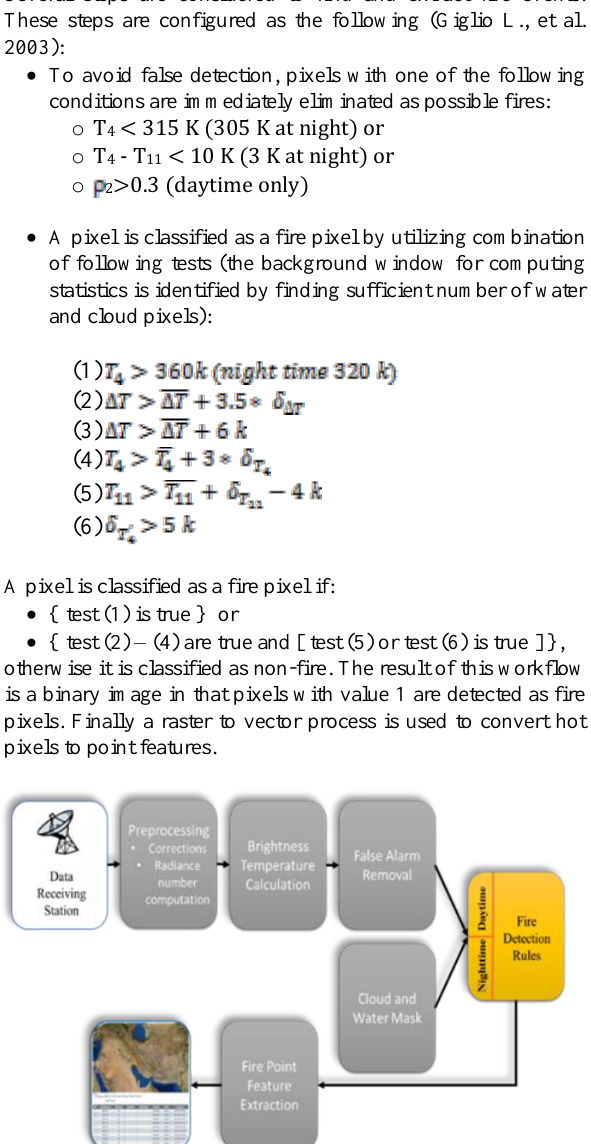
Figure 1. Sequences of fire detection processes